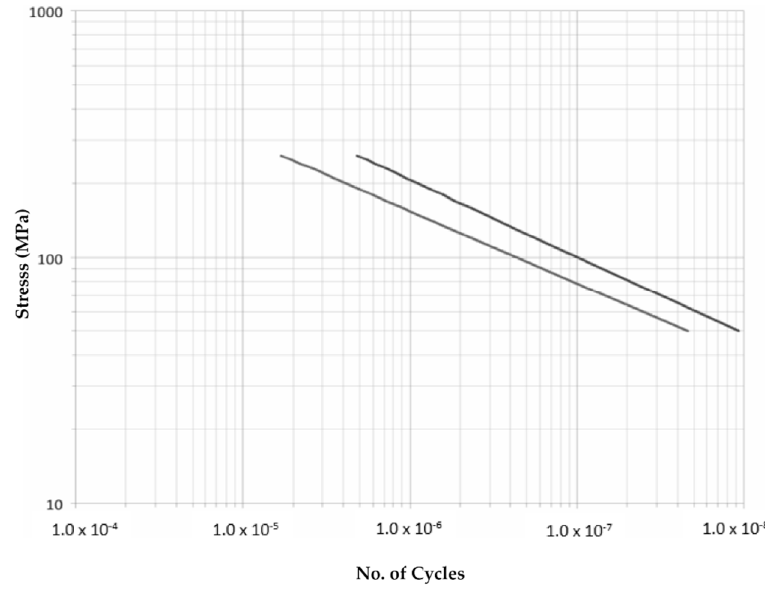
Figure 17. Bembézar S (MPa)-N approximation. Dark: Strings, Light: Chords.